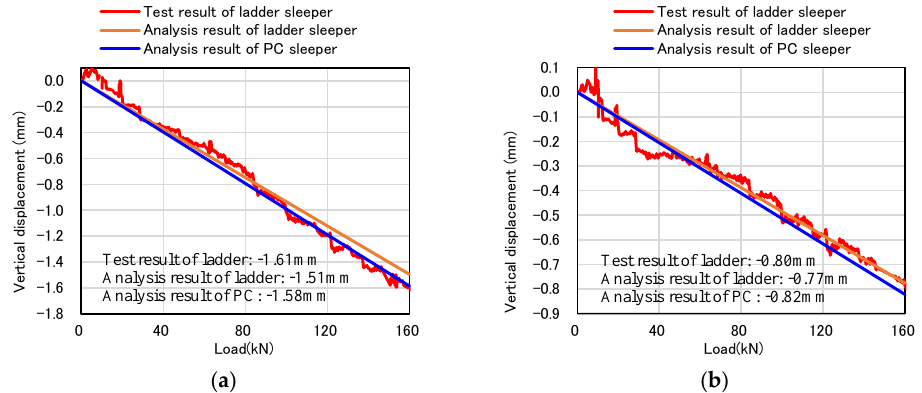
Figure 14. Comparison between the static loading test results and the analysis results: ( a ) rail; ( b ) sleeper.